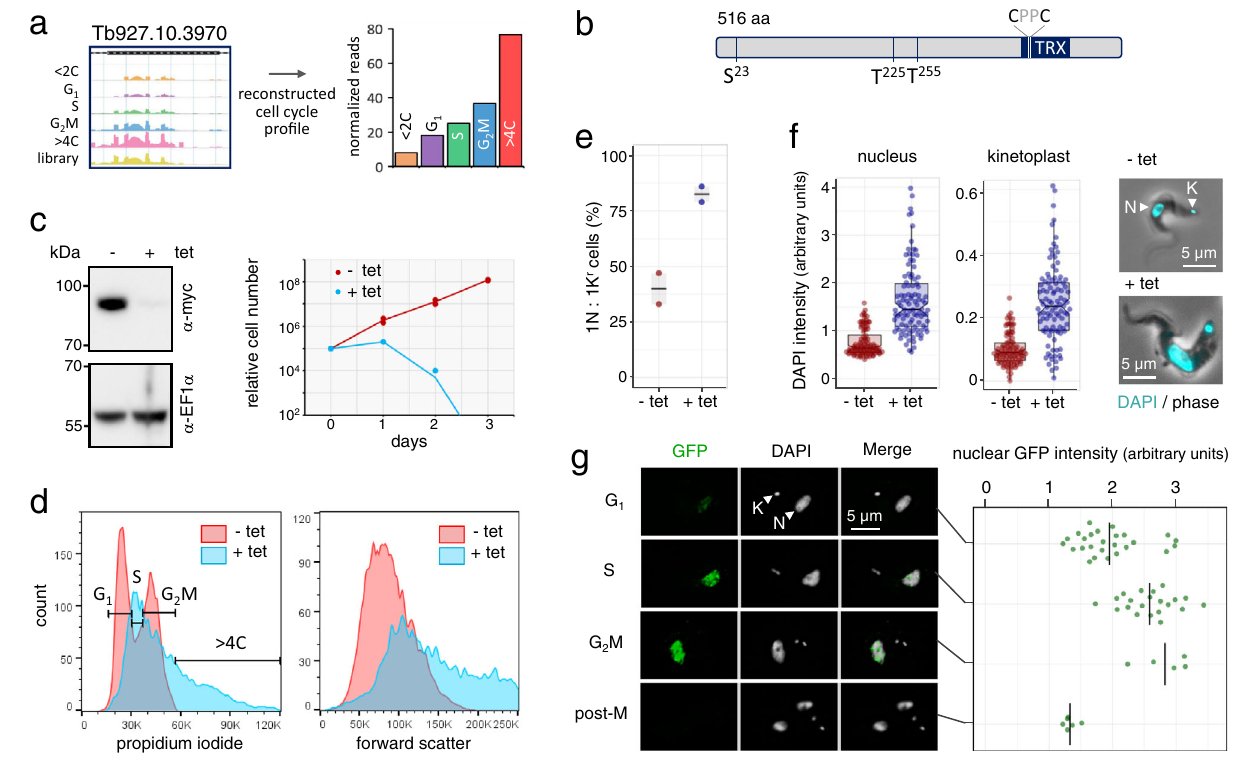
Fig.8|Aputativenucleoredoxincontrolskinetoplastsegregationandmitosis. a Mappedreadsandreconstructedcellcyclepro fi lefollowing10.3970knockdown. b Schematic map of the putative nucleoredoxin encoded by 10.3970. TRX thioredoxin-likedomain. c Theproteinblotsontheleftrevealef fi cienttetracycline (tet)-inducedknockdownof N -terminalmyc-tagged10.3970foronerepresentative clone after 24h. EF1 α serves as a loading control. The growth curve on the right reveals a severe growth defect following knockdown. n =2 biologically indepen- dent clones and theline indicates mean values. d